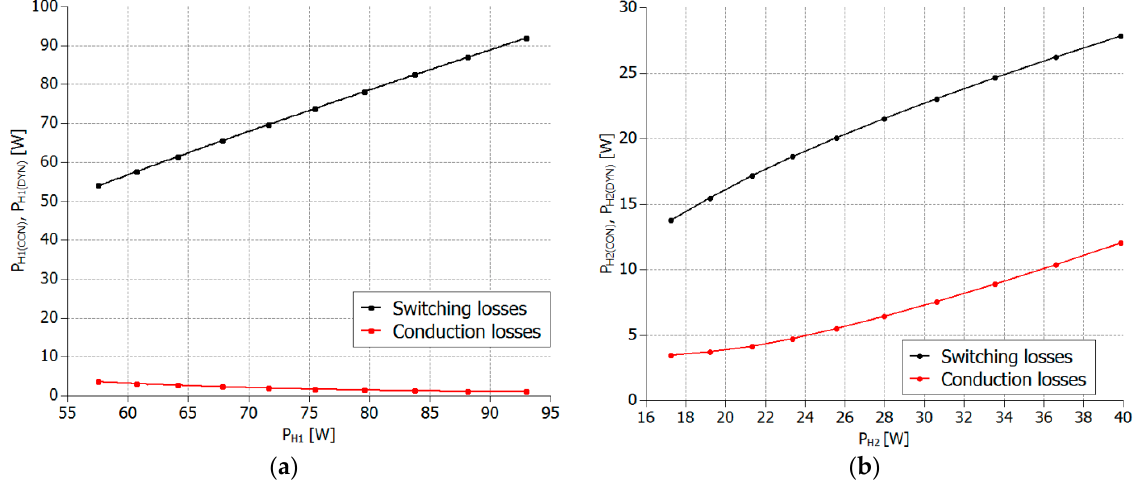
Figure 17. Estimated power loss distribution in the considered DAB converter bridges: ( a ) bridge H 1 ; ( b ) bridge H 2 .